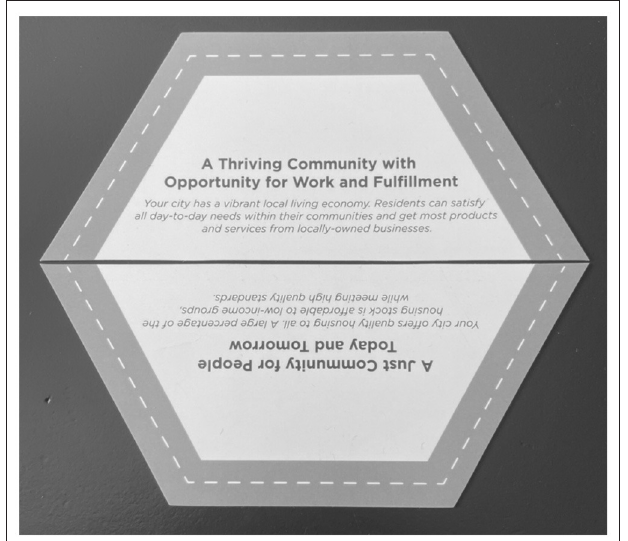
FIGURE 1 | Picture of two transformational sustainability goal